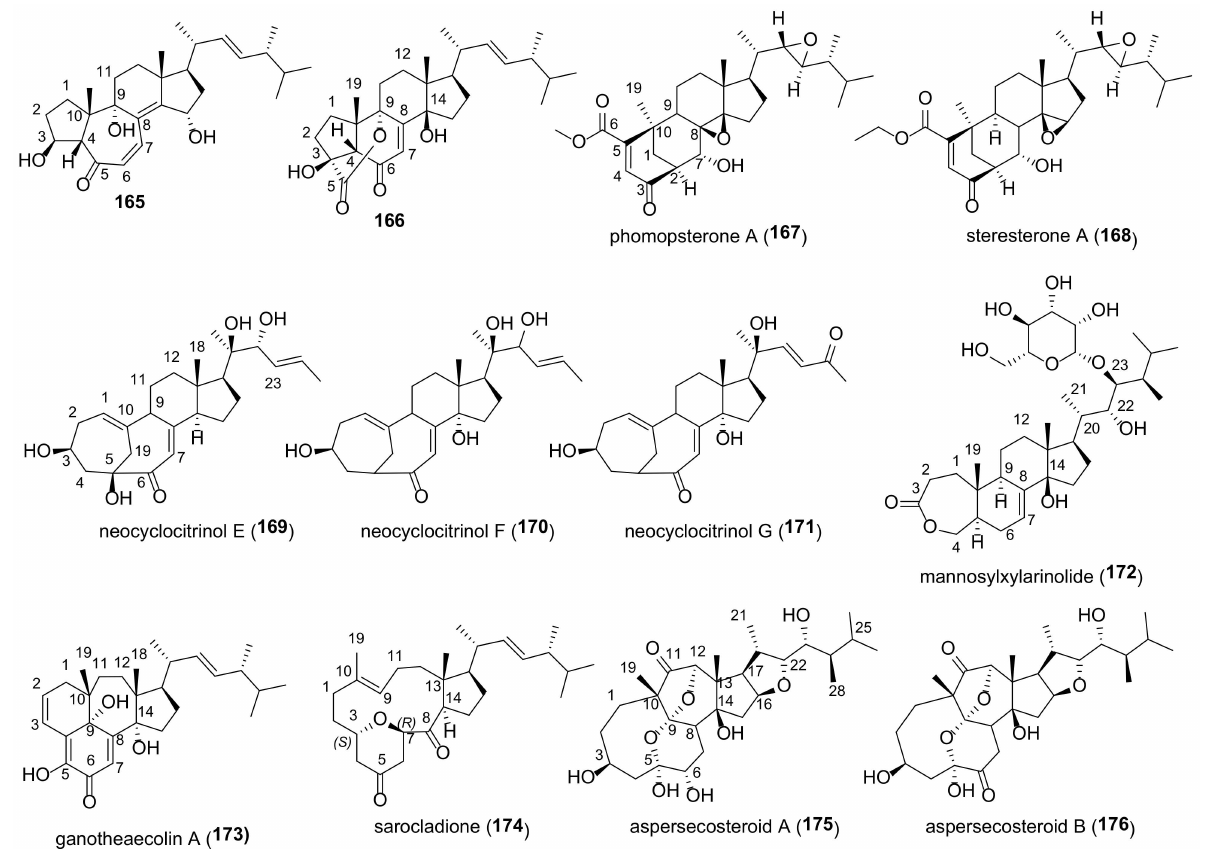
Figure 18. Structures of ergostanes with a rearranged